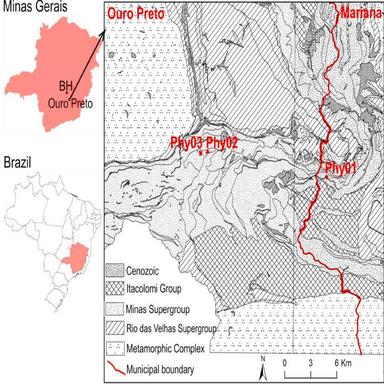
Geological map with the location of the studied weathering profiles, located in the contiguous cities of Mariana (Phy01) and Ouro Preto (Phy02 and Phy03) (adapted from; and).